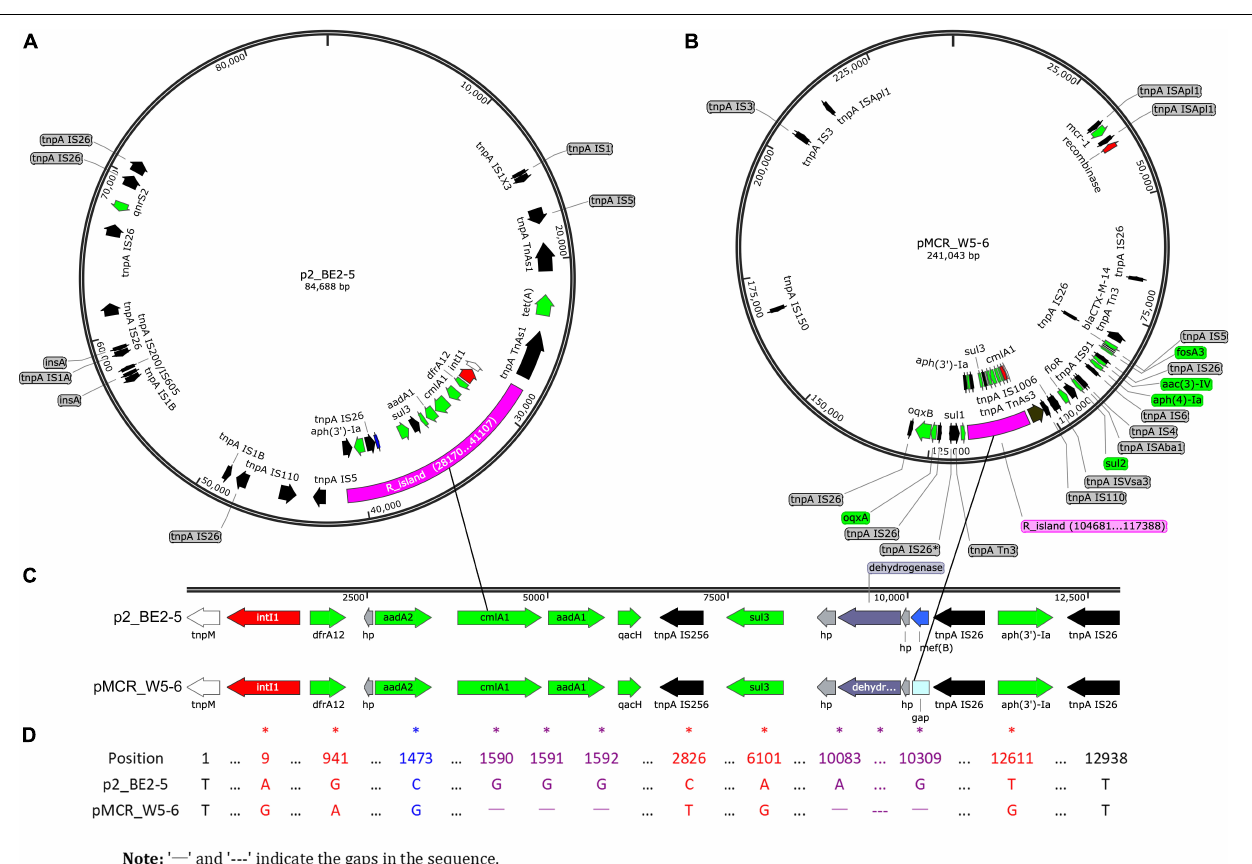
FIGURE 1 | Sequencing evidence for horizontal transfer of ARGs between the environmental (polluted Jin River) and avian (egret) E. coli . (A,B) Exhibit the distribution of ARGs (green arrows) and MGEs on plasmids p2_BE2-5 and pMCR_W5-6, respectively. The MDR regions (R_island) of the similar structure are indicated as purple fragments on both plasmids. Their structures in detail are illustrated in (C) , and the sequence alignment of two R_islands is exhibited in (D) . The MDR region is composed of one integron (red arrows indicate site-specific integrase/recombinase genes) and one IS 26 _ aph(3 (cid:48) )-Ia _IS 26 composite transposon (black arrows for transposase genes, tnpA IS 26 etc.). The recombination event ( mef(B) gene) in the MDR region is indicated in blue ( A,C , on plasmid p2_PE2-5). The mismatches between sequences were indicated with asterisks in (D) . A BRIG-Easyfig version of this figure is shown in supporting information as Supplementary Figure S4